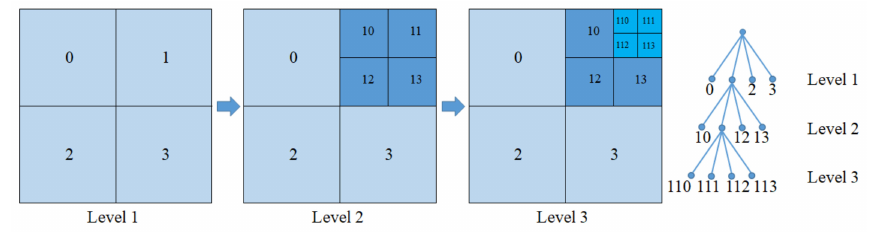
Figure 4. Layer-by-layer discretization in DH-PD